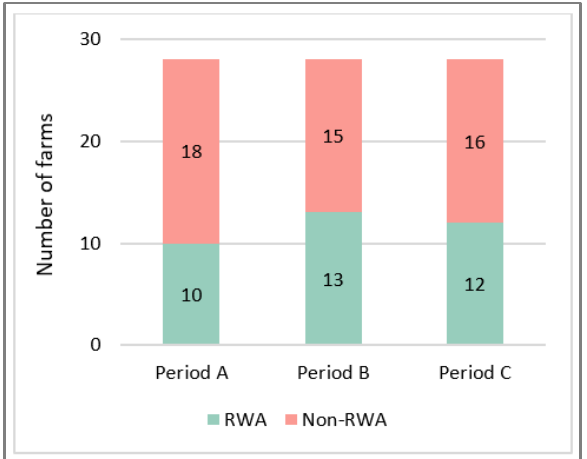
Figure 4. Number of farms producing according to the Raised Without Antibiotics (RWA) program, and number of non-RWA farms in the different periods of the study